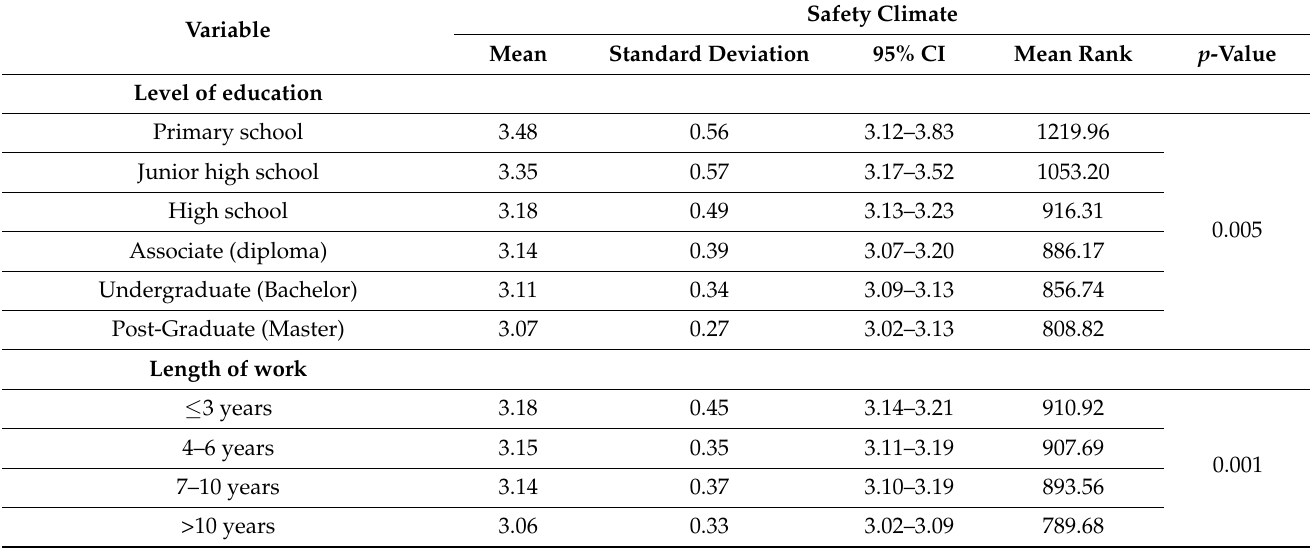
Table 5. Difference of the safety